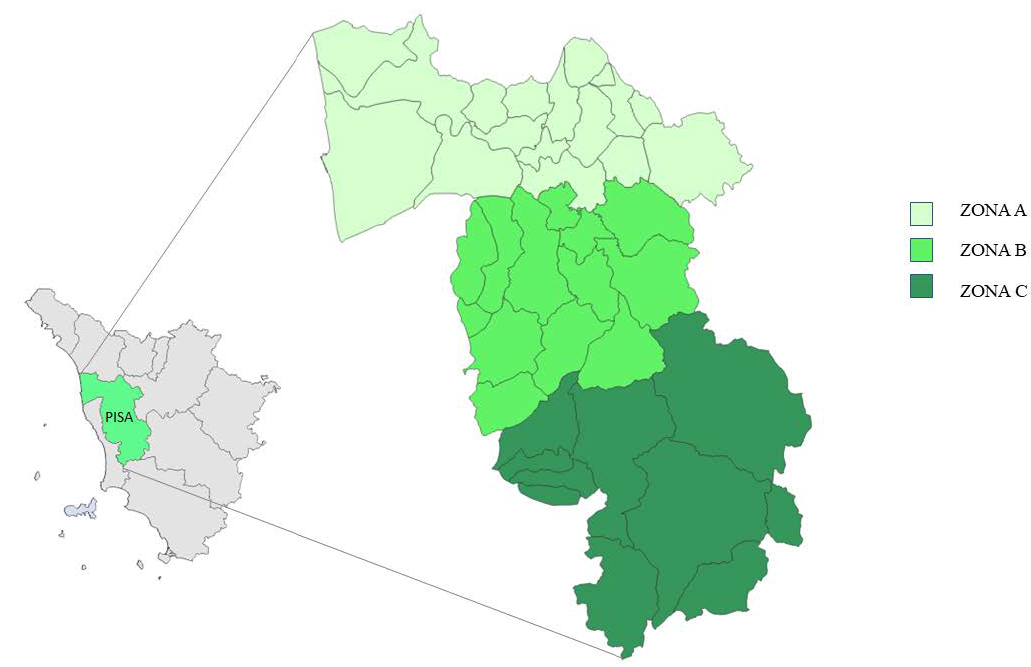
Figure 1. Map of the province of Pisa divided into the 3 zones.